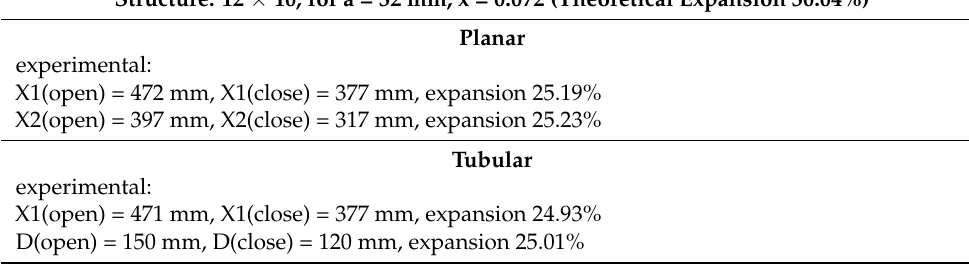
Table 3. Comparison of the measured and theoretical values for the planar structure and the resulting tubular